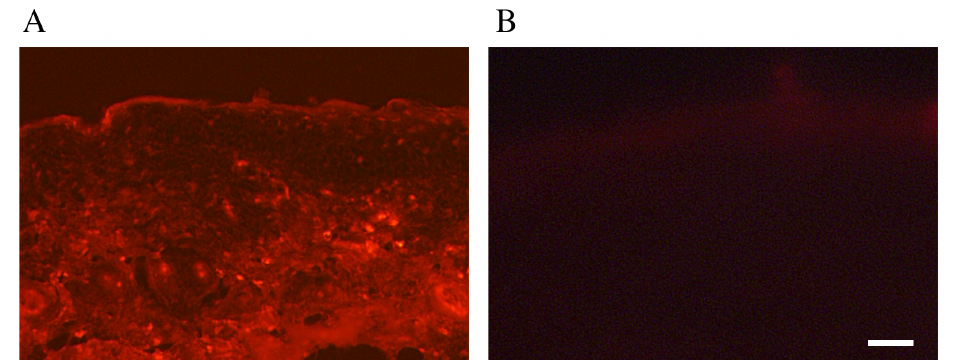
Figure 3. Distribution of transdermally administered adriamycin. Adriamycin cream was topically applied to the skin of hairless mice for three consecutive days with ( A ); or without ( B ) pretreatment with a depilatory agent. The distribution of adriamycin was then detected based on its autofluorescence. Adriamycin was observed in the dermis/fascia only after pretreatment with the depilatory agent. Scale bar = 10